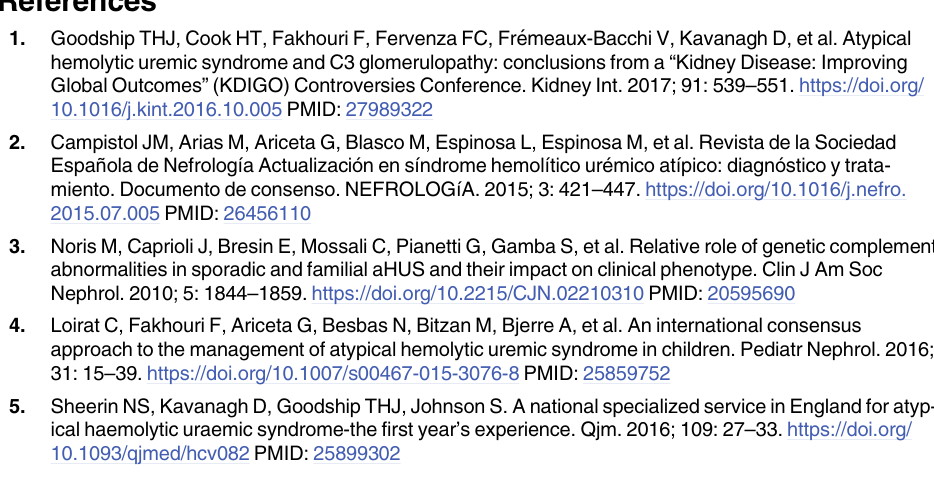
S1 Fig. Results of genetic analysis in cases submitted to genetic analysis (n = 19) in the Bra- zilian aHUS cohort in kidney transplantation. S1 Table. The demographic data and complete genetic analysis in the Brazilian aHUS cohort in kidney transplantation. S2 Table. The frequency of variants divided by groups: No eculizumab use, eculizumab treatment, and prophylactic eculizumab in the Brazilian aHUS cohort in kidney transplan- tation. S3 Table. Cause of mortality in the Brazilian aHUS cohort in kidney